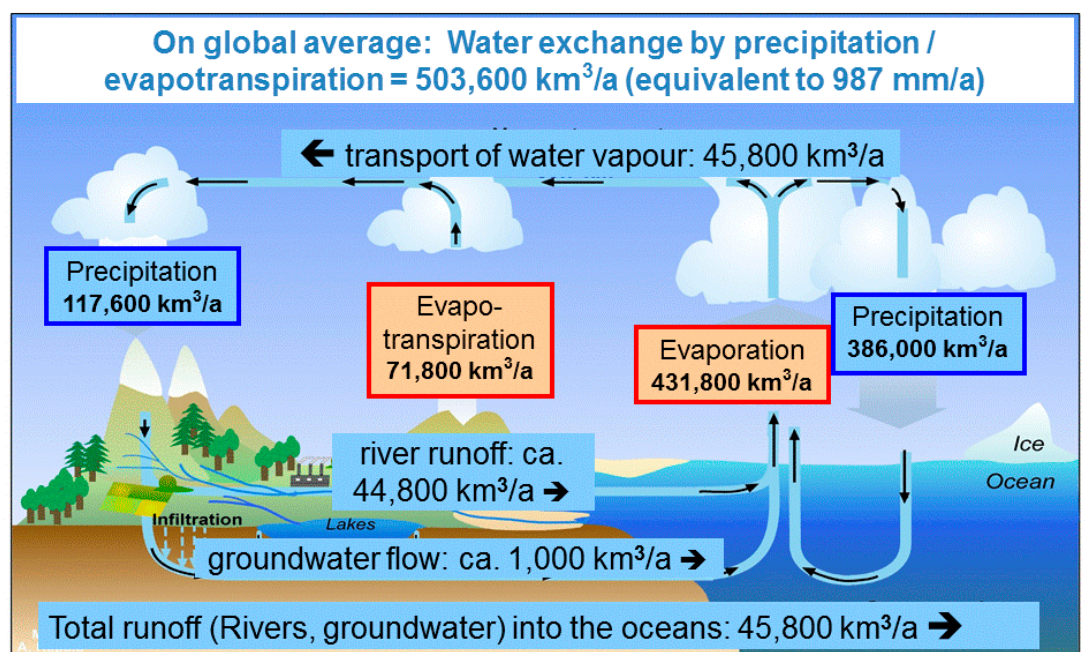
Figure 11. Average water transport/exchanges in km 3 per year as derived from GPCC’s precipitation climatology for 1951–2000 land surface precipitation, numbers for precipitation over oceans, evapotranspiration/evaporation over land/ocean taken from [13,14], background picture by courtesy of A. Kapala (Meteorological Institute, University Bonn).